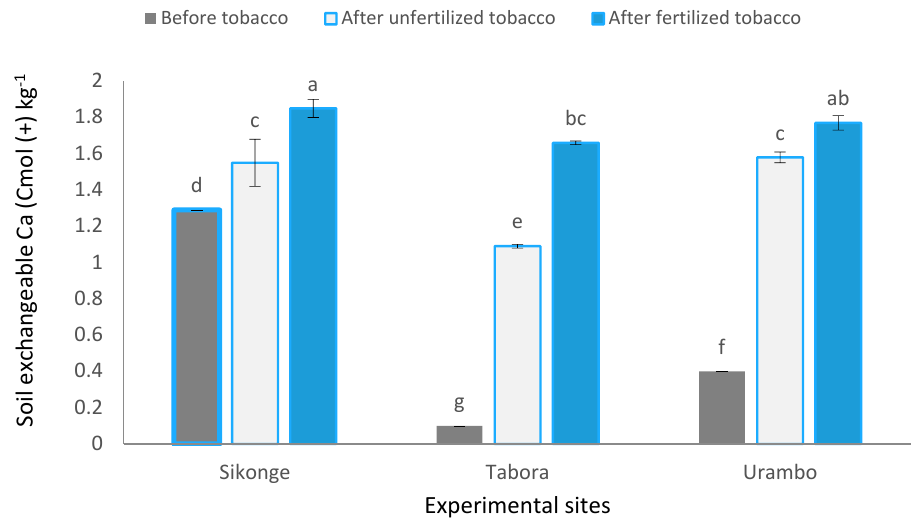
Figure 7. Effect of tobacco and fertilization on soil Ca. ‘a’ & ‘ab’ are very highly significant; ‘bc’ & ‘c’ are highly significant; ‘d’ & ‘e’ are significant; ‘f’ & ‘g’ non